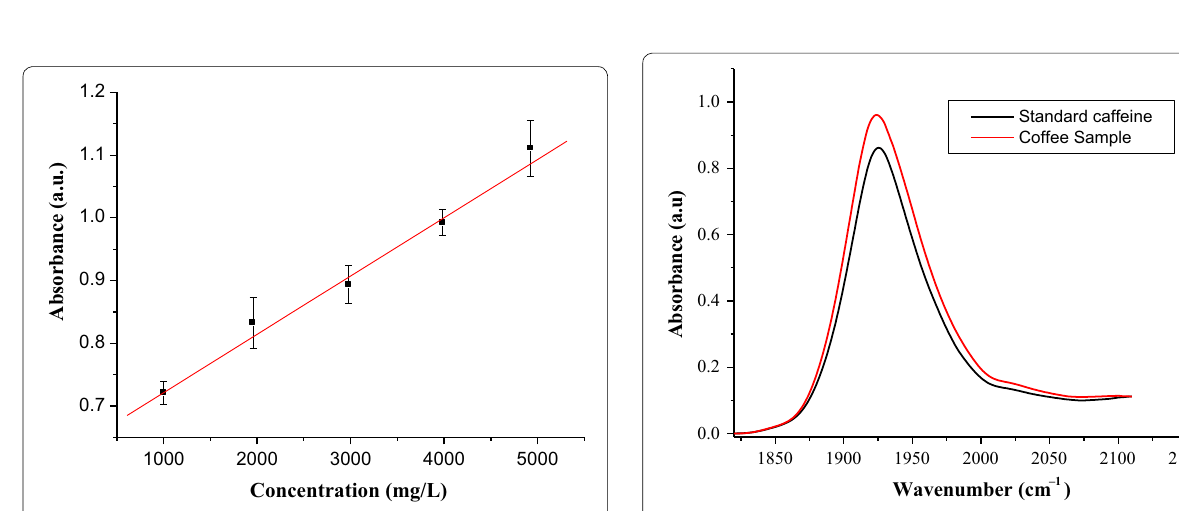
Fig. 4 Absorbance versus concentration graph of standard caffeine Fig. 5 NIR spectrum of standard caffeine and coffee dissolved in